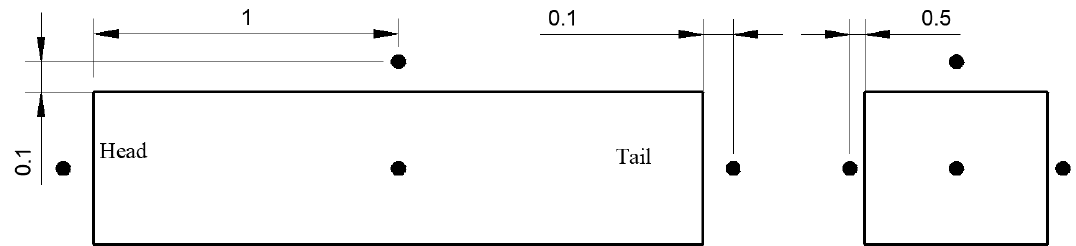
Figure 3. Location map for the pig body surface comfort test (unit: m).